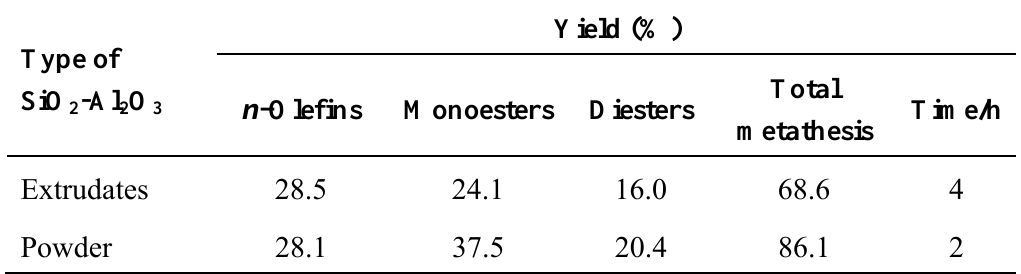
O /SiO -Al O /SnBu catalytic system [substrate (0.5 mL), catalyst (0.2 g), 2 7 2 2 3 4